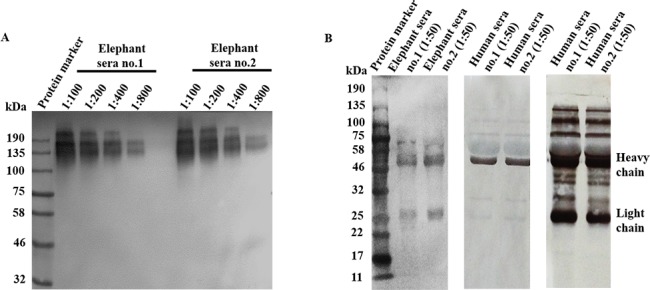
Binding efficiency of protein A/G-HRP to elephant serum Ig.(A) Under non-reducing conditions: protein A/G conjugate binds elephant IgG molecule at the MW of 150 kDa; (B) Under reducing conditions: protein A/G conjugate binds both H chain and L chain of elephant IgG with MW of 50 and 25 kDa, respectively (left panel). These MWs are identical to those of human IgG which reacts with HRP conjugated-goat anti-human IgG, IgM, IgA (H+L) and shows various bands of proteins with different MWs, suggesting of H chains and L chains of different Ig classes (right panel). The result also demonstrated that H chain, but not L chain of human Ig, binds protein A/G efficiently (middle panel).